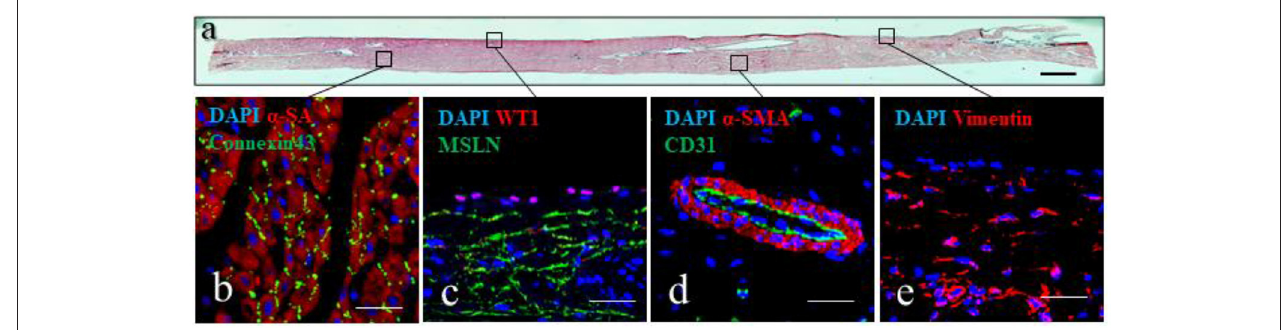
FIGURE 5 | Epicardial slices structure analysis. (a) Tissue architecture evaluation of epicardial slices performed using hematoxylin and eosin coloration. Scale bar, 500 µ m. (b–e) Immunohistochemical staining and confocal microscopy of epicardial slices. (b) Cardiomyocytes are stained with α -sarcomeric actin and the intercalated disk is stained with connexin-43 antibody. (c) Epicardial cells highlighted with WT1 and mesenchymal derived cells stained with MSLN. (d) Microvasculature is stained with α - smooth muscle actin and the endothelial marker CD31. (e) Mesenchymal cells are stained with vimentin. Nuclei are labeled with DAPI. Scale bars, 50 µ m.